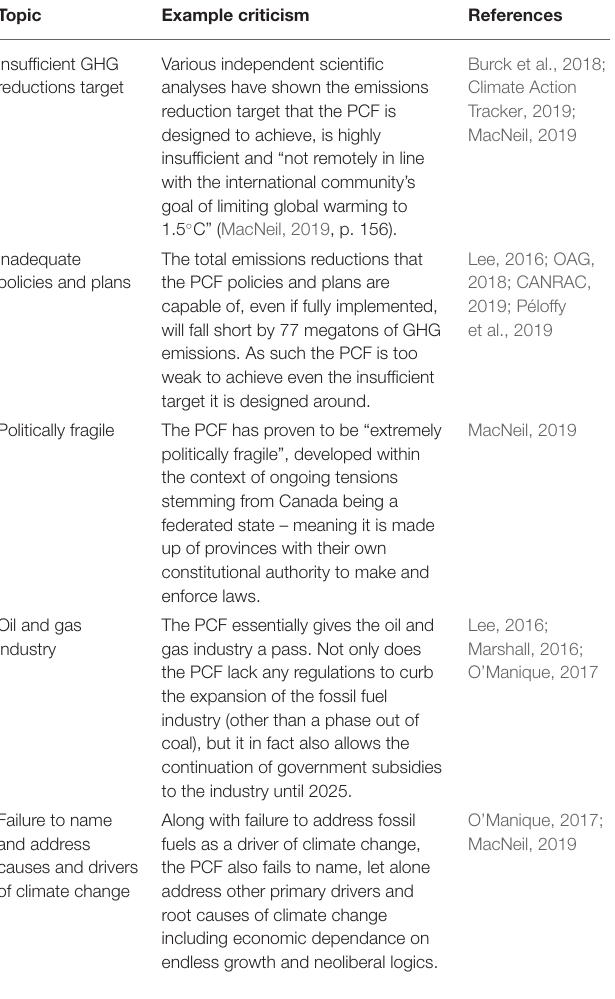
TABLE 4 | Summary of other, existing critiques of the